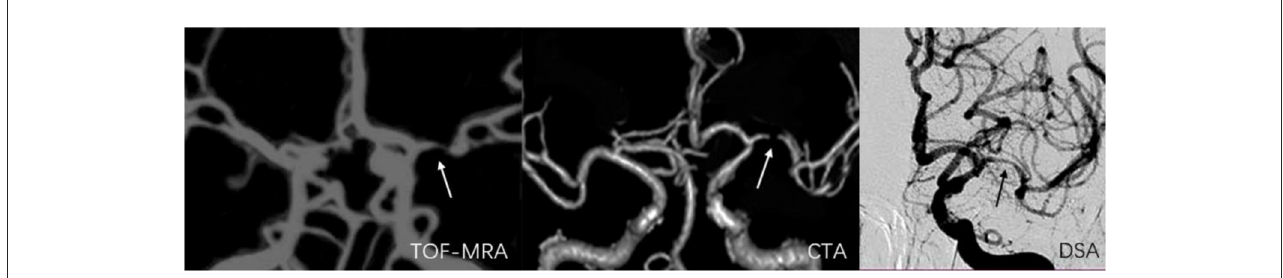
FIGURE6 A 55-year-old man with stenosis on the bifurcation and bend of the left middle artery. The arrow marks the location of the lesion. The degree of stenosis acquired on TOF-MRA (75.3%) and CTA (92.5%) exceeded that on DSA (56.9%).